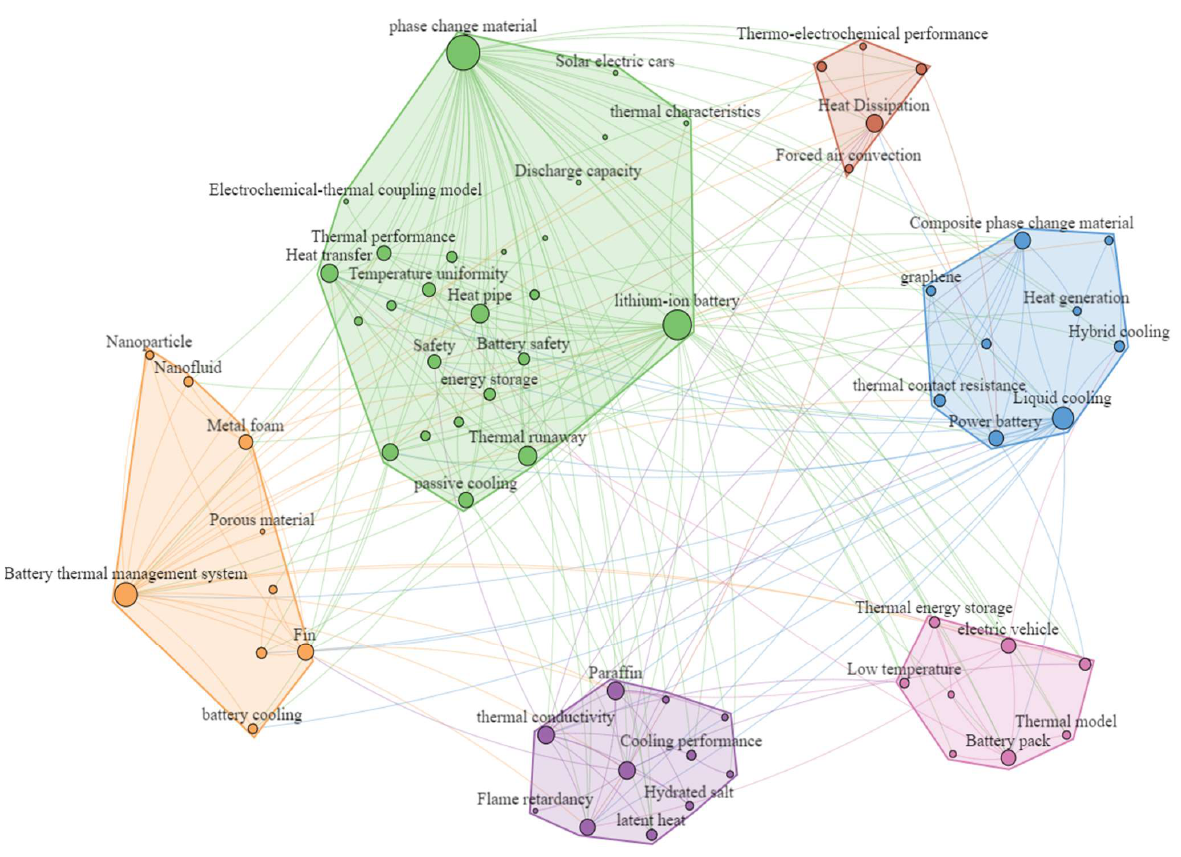
Figure 6. Keywords cluster of the research articles.